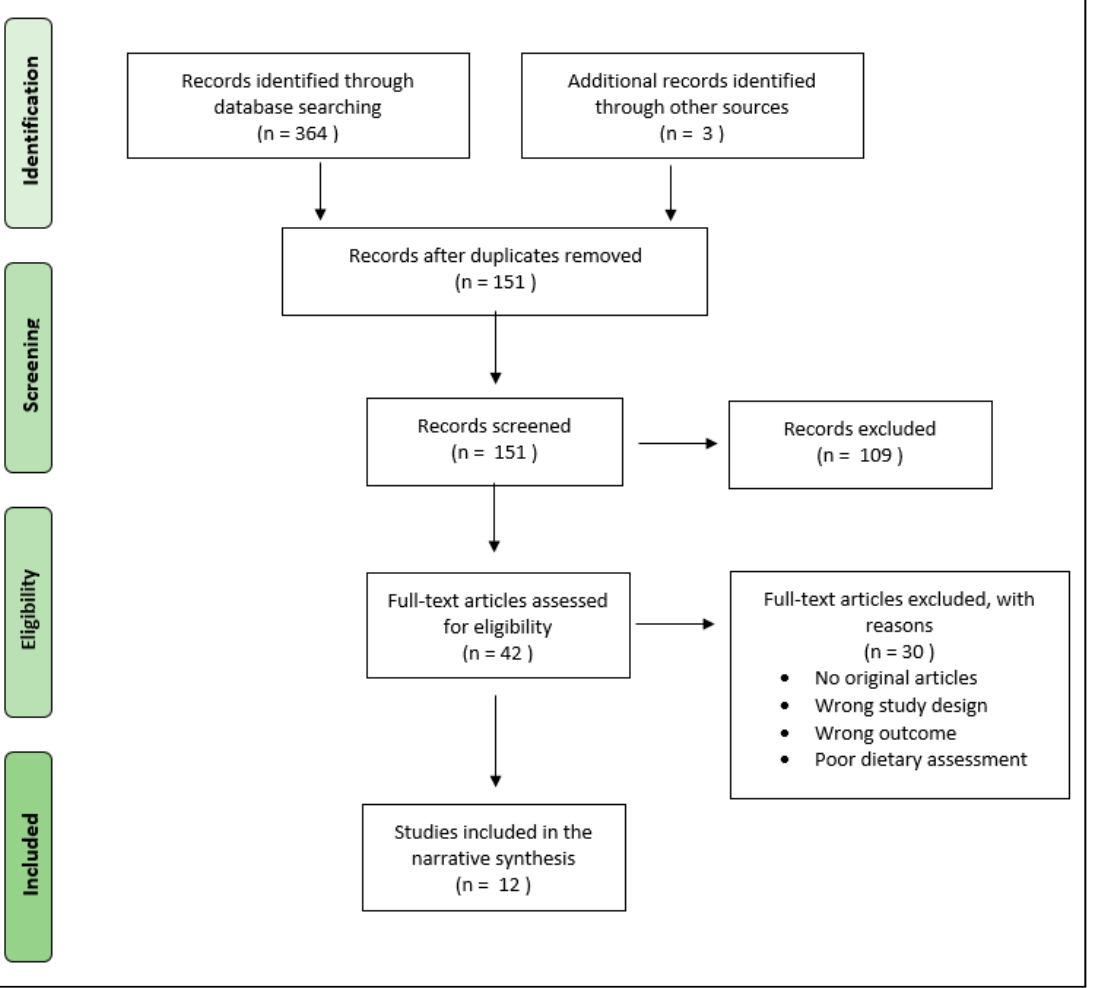
Figure 1. Preferred Reporting Items for Systematic reviews and Meta-Analyses (PRISMA) flow diagram of search procedure.